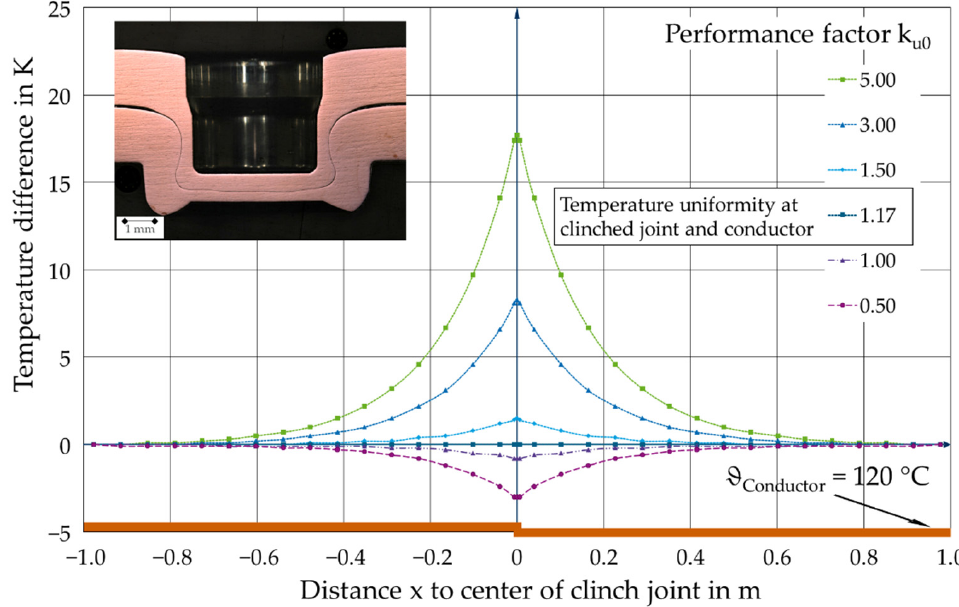
Figure 5. Distribution of the temperature at a temperature of 120 °C on the unaffected conductor depending on the performance factor k u0 of longitudinal connections with contact partners made of Cu-ETP.